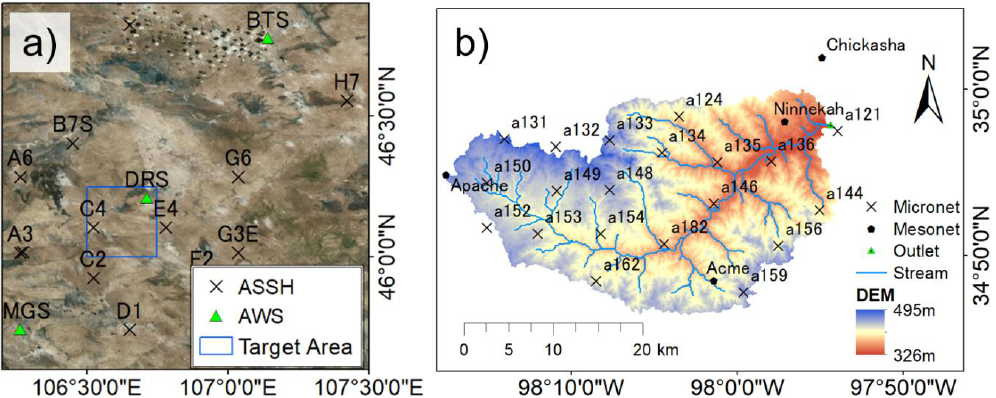
Figure 2. Maps of the target areas and observation stations. ( a ) CEOP / Mongolia reference site; ( b ) Little Washita Basin. Digital elevation model (DEM) was obtained from the National Elevation Dataset provided by the United States Geological